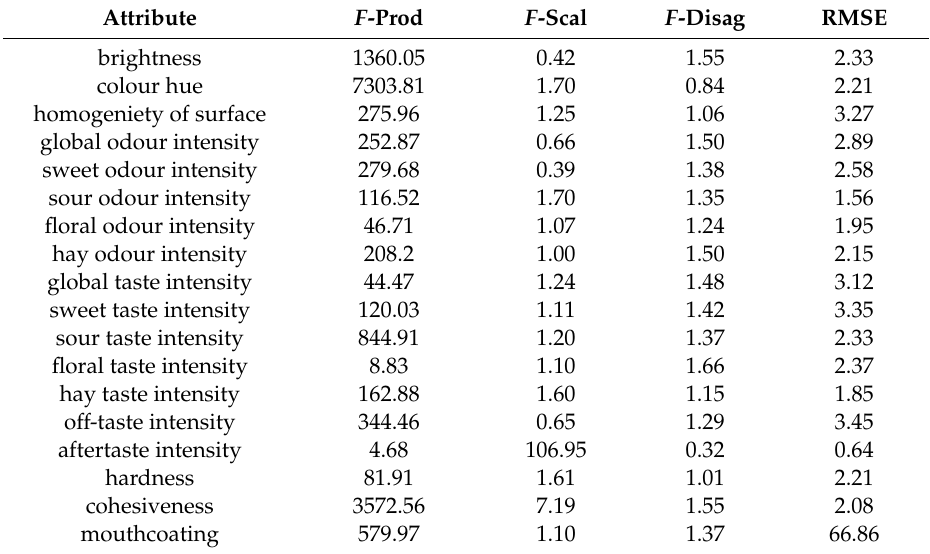
Table 4. The sensory panel performance MAM-CAP table. The first column contains the mean of the panel for each attribute. The four following columns are respectively: F statistics of discrimination ( F -Prod), scaling heterogeneity ( F -Scal), disagreement ( F -Disag), and repeatability (root mean squares of error,